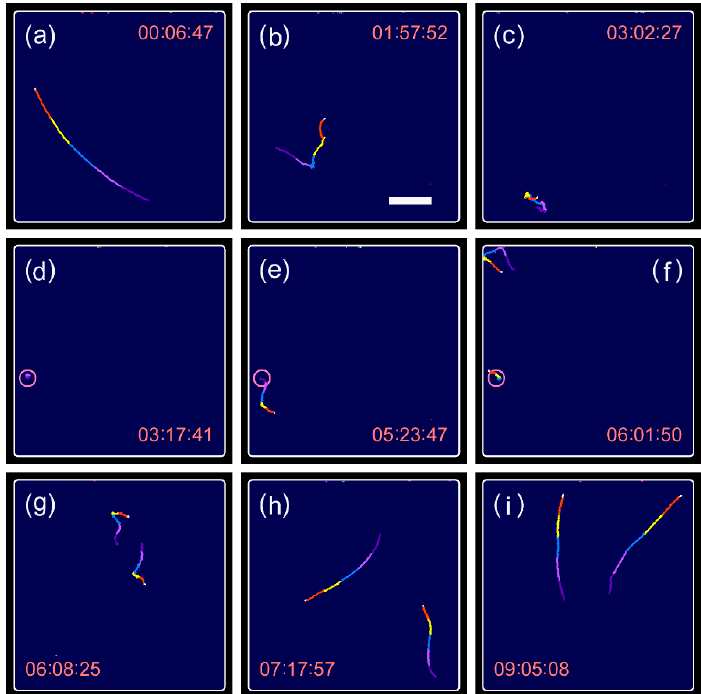
Figure 9. Swimming traces observed in a long-term millimeter-scale observation, including the period of cell division. ( a – d ) Movements of the parental cell, ( e – i ) movements of the daughter cells. In the images shown in ( a – i ), the traces obtained for the last 12.3 s (5 frames × 2.47 s/frame) were superimposed with different colors for visualization. Circles in ( d – f ) show the location where the cell division occurred. Refer to supplementary movie S6 for visualizing the entire process. Time index in the panels is indicated by hh:mm:ss. Scale bar, 500 μ m.